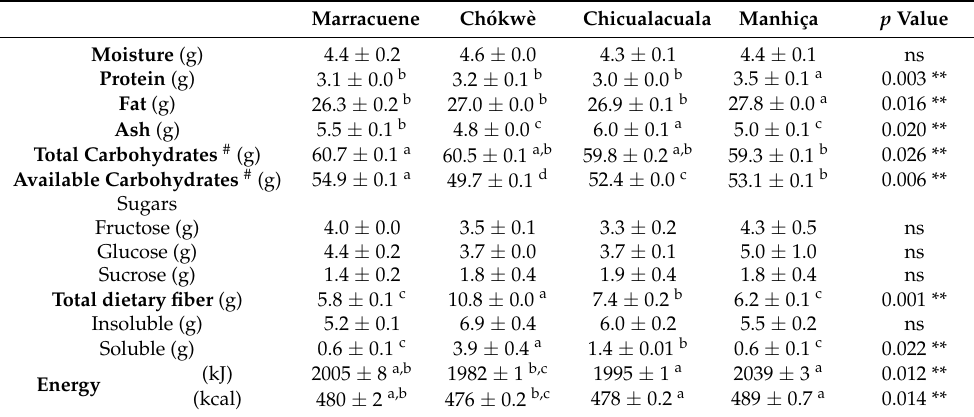
Table 1. Proximate composition, energy value, sugar and fiber profiles (%) of S. madagascarien- sis fruit flour ( nfuma ) from four districts (Marracuene, Manhiça, Ch ó kw è and Chicualacuala) in southern